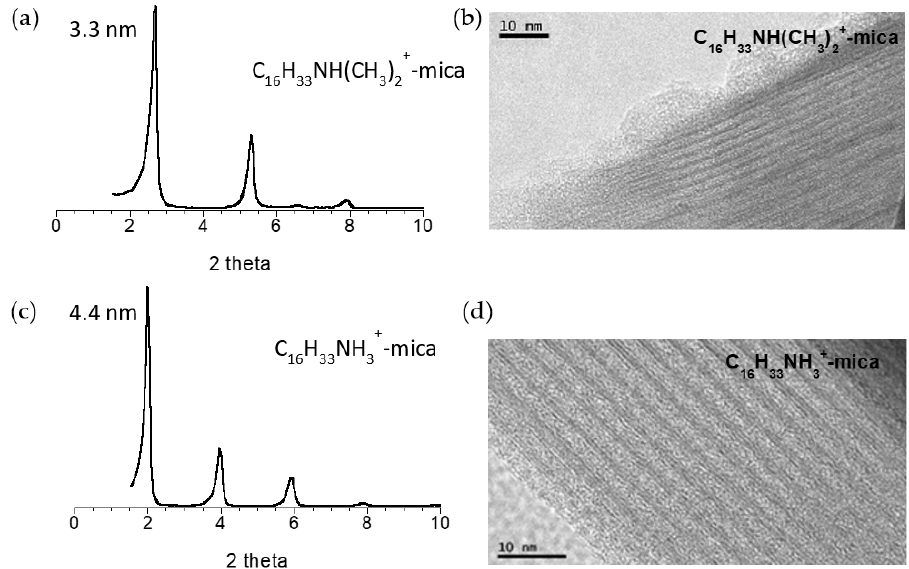
Figure 1. XRD patterns of the amphiphilic mica, C 16 H 33 NH(CH 3 ) 2+ -mica ( a ), and the organo-mica, C 16 H 33 NH 3+ -mica ( c ); and TEM images of the amphiphilic mica ( b ) and the organic-mica ( d ).